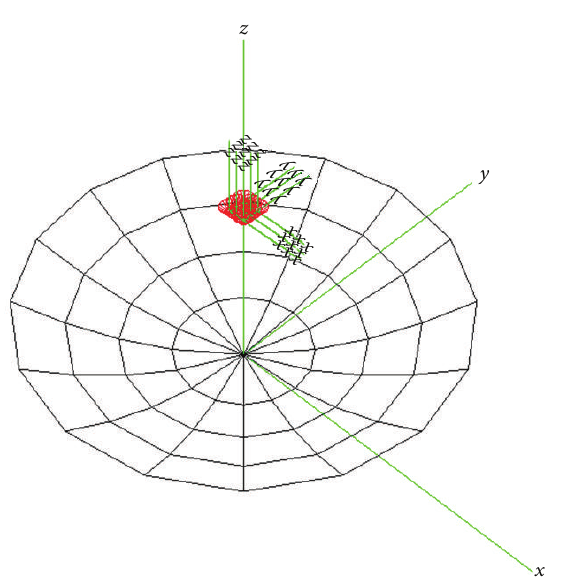
Figure 25: Single reflector feed with a 2D array of horns.